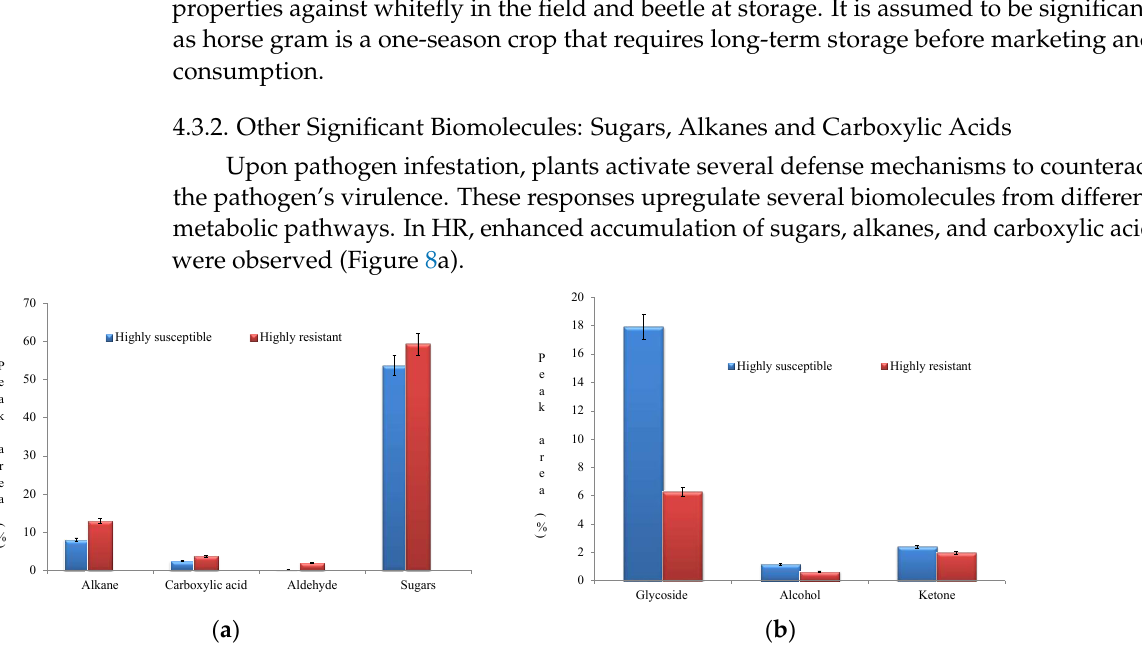
Figure 8. ( a ) Enhanced accumulation pattern of biomolecules in the highly resistant genotype. ( b ) Enhanced accumulation pattern of biomolecules in the highly susceptible genotype. Sugars act as signaling molecules in host-pathogen interaction [51,52] and immu- nity [53]. HgYMV induced the accumulation of a rare sugar, D-Allose, which upregulates many defense-related PR-protein and associated genes